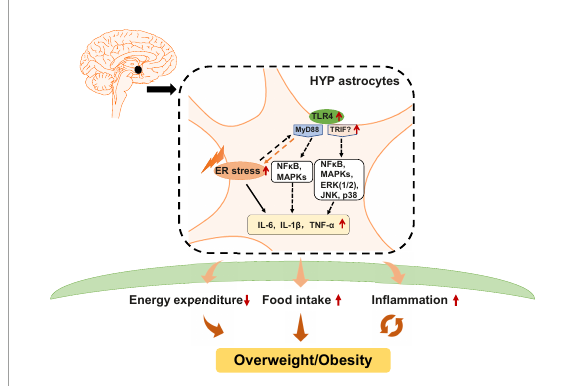
FIGURE2 Potential role of astrocytic endoplasmic reticulum (ER) stress and Toll-like receptor 4 (TLR4) signaling in obesity and inflammation. In hypothalamic astrocytes, ER stress may activate TLR4 that then activates myeloid differentiation primary response 88 (MyD88)-independent and MyD88-dependent signaling, which increases the expression of nuclear factor κ B (NF- κ B), mitogen-activated protein kinases (MAPKs), extracellular signal-regulated kinase 1/2 (ERK1/2), c-Jun N-terminal kinase (JNK), and p38. These effects upregulate pro-inflammatory cytokines such as interleukin 6 (IL-6), IL-1 β , and tumor necrosis factor alpha (TNF- α ), and causing central inflammation. Activated astrocytic TLR4 signaling could also lead to decreased energy expenditure and promote ER stress activation, which increases food intake, eventually leading to